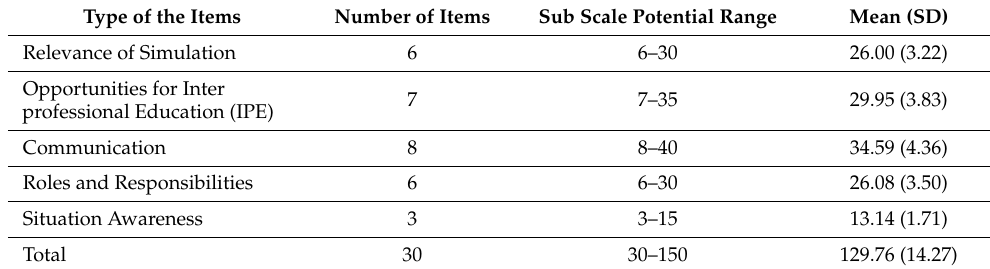
Table 3. The mean total of the students’ scores on the five subscales of the KidSIM questionnaire.